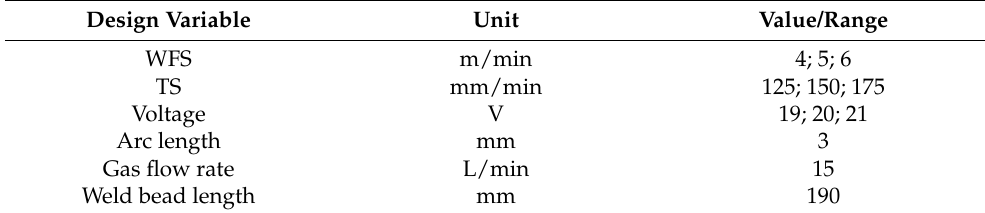
Table 2. Design variables used in present study with their value/range.